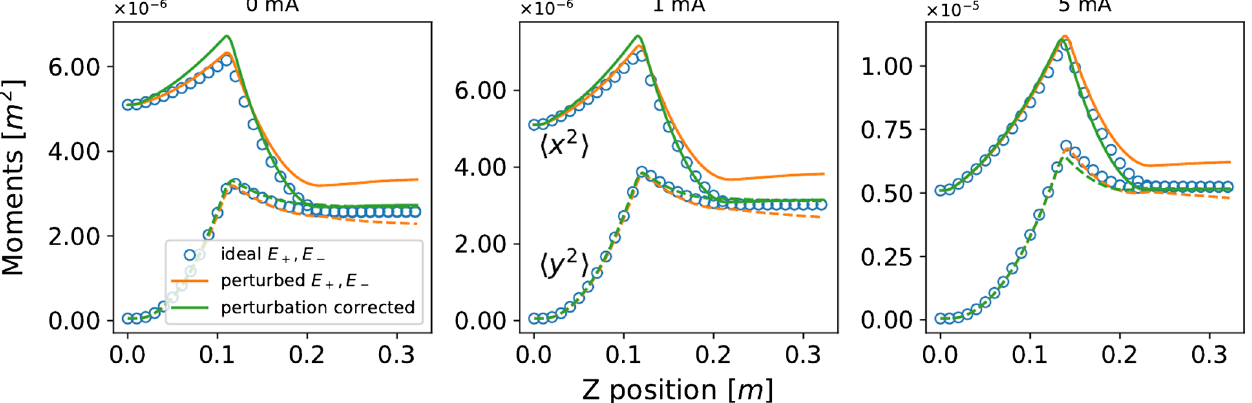
FIG. 7. rms beam size is plotted for optimized results with ideal initial conditions (blue circles). Initial conditions are purposely perturbed to break the optimized results (orange line). Magnet parameters are reoptimized to correct for the perturbed initial conditions (green line).